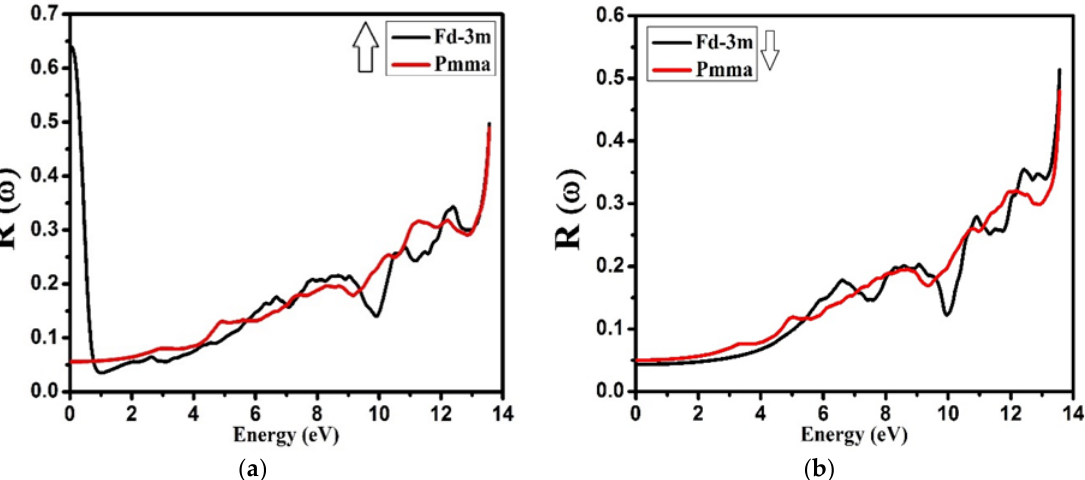
Figure 11. Calculated reflectivity R ( ω ) for Nd 2 Zr 2 O 7 ((black color for Fd-3m) and (red color for Pmma)) using GGA+U. ( a ) The spin-up direction ( ↑ ) and ( b ) spin-down ( ↓ ) direction.